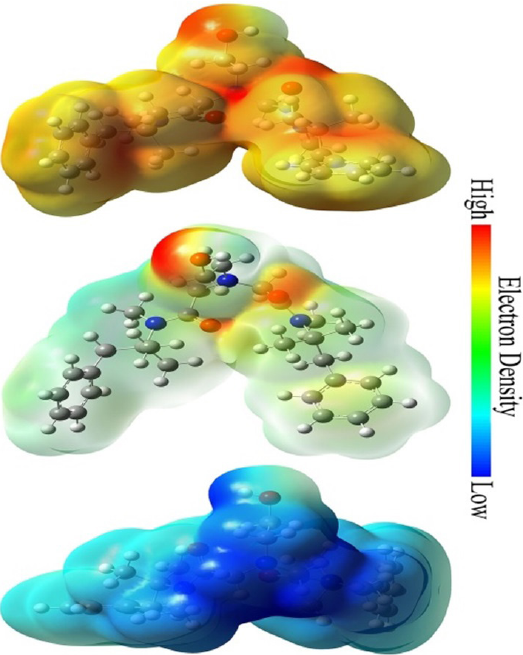
Figure 11. Iso-surface representation of electrostatic potential of 2,2’-(2-Hydroxyethylimino)bis[N-(alphaalpha-dimethylphenethyl)-N- methylacetamide] as a system based on the independent single-point calculation for corresponding N+1 , N and N-1 electron systems, top to bottom respectively, at the B3LYP/6-31G(d,p)